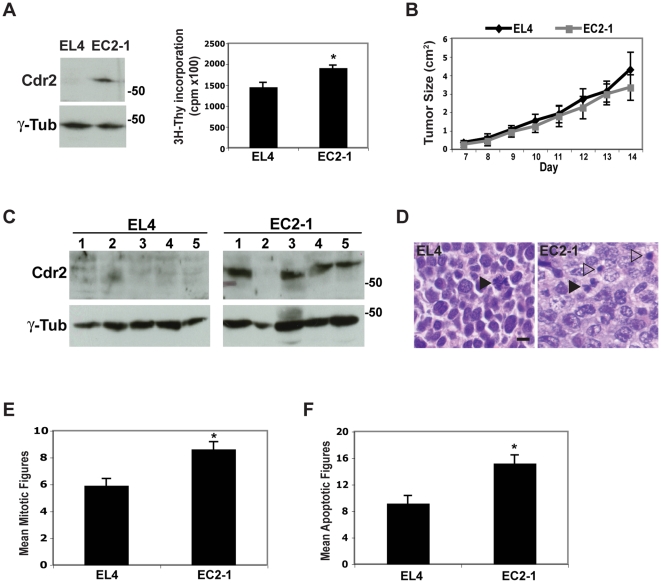
Cdr2 overexpression in tumors drives the cell cycle.A. Western blots of EL4 and EC2-1 extracts probed with cdr2 and γ-tubulin antisera (left) and steady state proliferation (3H-thymidine incorporation (cpm)) of EL4 or EC2-1 cells lines (right); *p<0.05. B. Quantitation of tumor size (cm2) in EL4- (black) and EC2-1- (gray) injected nude mice at indicated days. C. Western blots of tumor extracts from mice injected with EL4 or EC2-1 cells probed with cdr2 and γ-tubulin antisera. D. Representative hematoxylin and eosin stains of EL4 (left) or EC2-1 (right) tumor sections (60X). Black arrowheads indicate mitotic figures; clear arrowheads indicate apoptotic figures. Scale bar = 10 µm. E. Quantitation of mitotic figures. *p<0.05. F. Quantitation of apoptotic figures; *p<0.05.